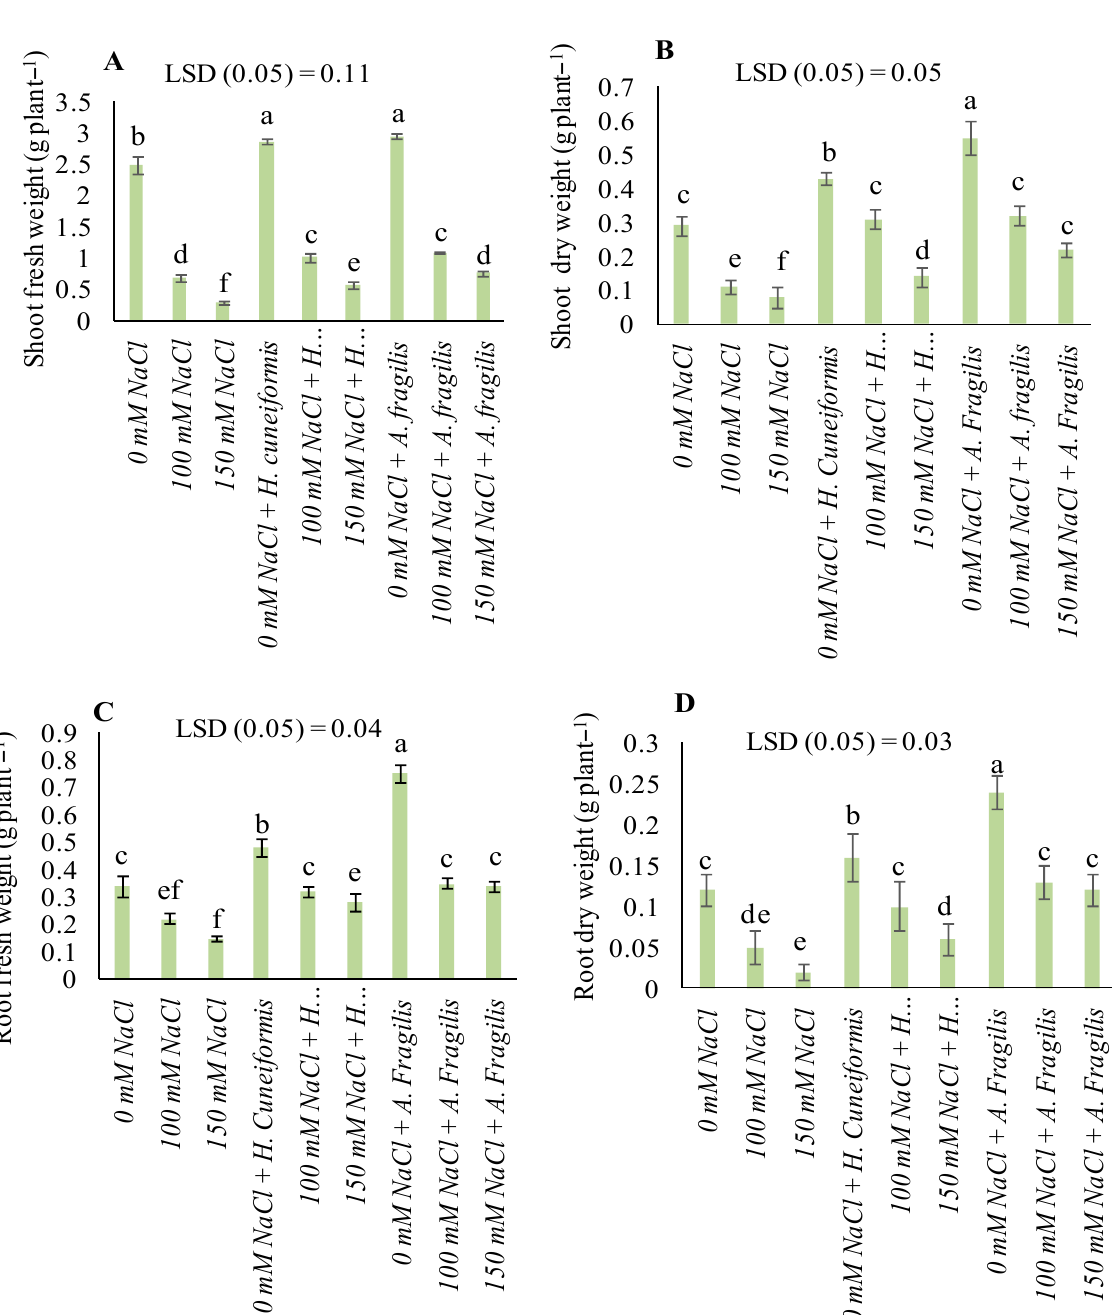
Figure 3. The effect of salinity stress on shoot fresh weight ( A ), shoot dry weight ( B ), root fresh weight ( C ) and root dry weight ( D ) of wheat ( Triticum aestivum L.) primed with H. cuneiformis and A. fragilis extracts. Treatments include 0 mM NaCl, 100 mM NaCl, 150 mM NaCl, 0 mM NaCl + H. cuneiformis , 100 mM NaCl + H. cuneiformis , 150 mM NaCl + H. cuneiformis , 0 mM NaCl + A. fragilis , 100 mM NaCl + A. fragilis , 0 mM NaCl + A. fragilis . Different letters for each mean show statistically significant differences according to the least significant difference (LSD) test ( p < 0.05).